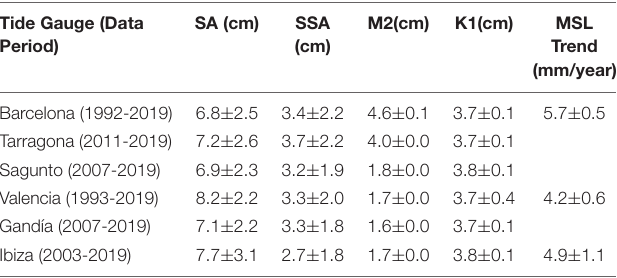
Column 6: MSL trend (mm/year) at each tide gauge from the monthly MSLs since